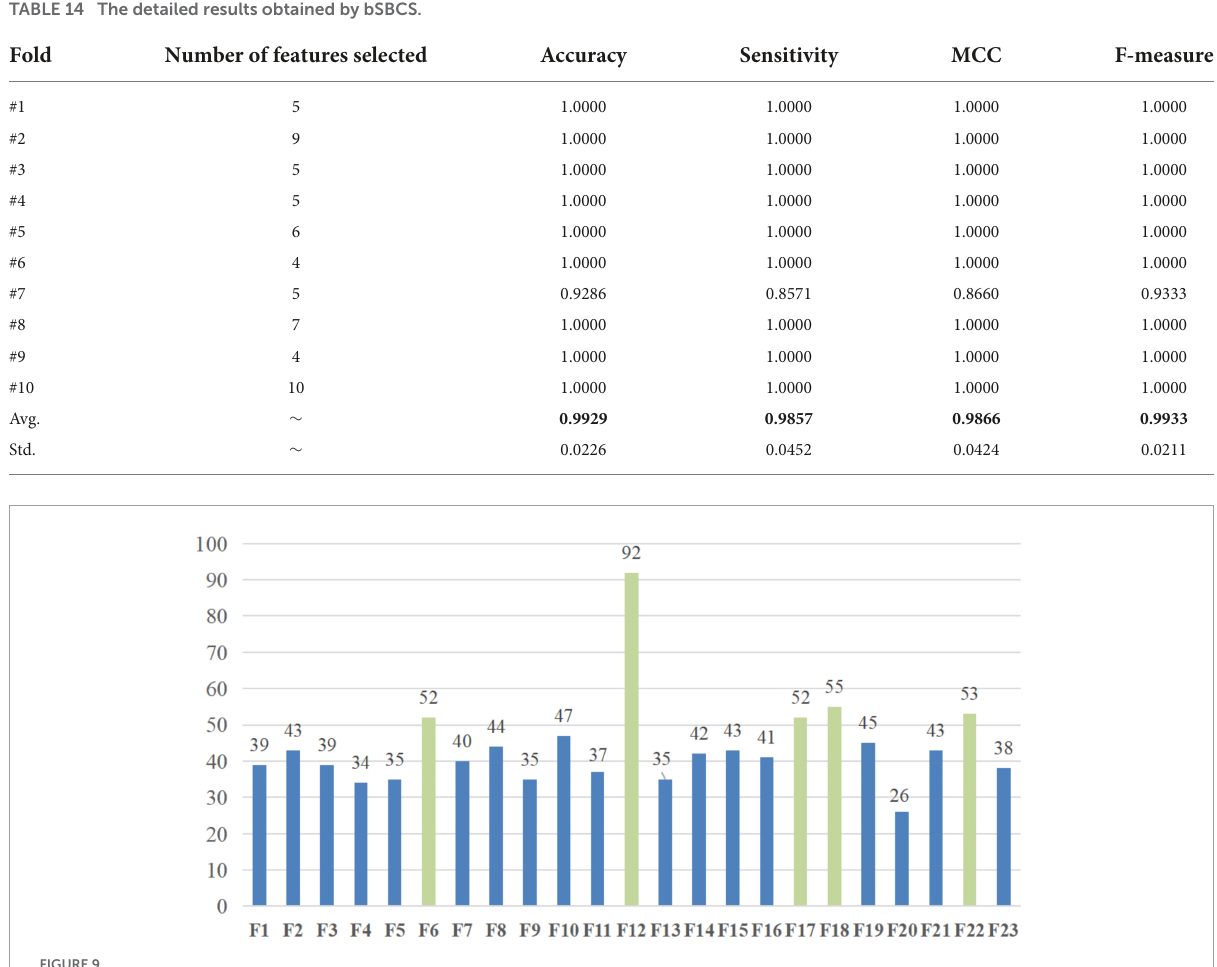
TABLE 14 The detailed results obtained by bSBCS.